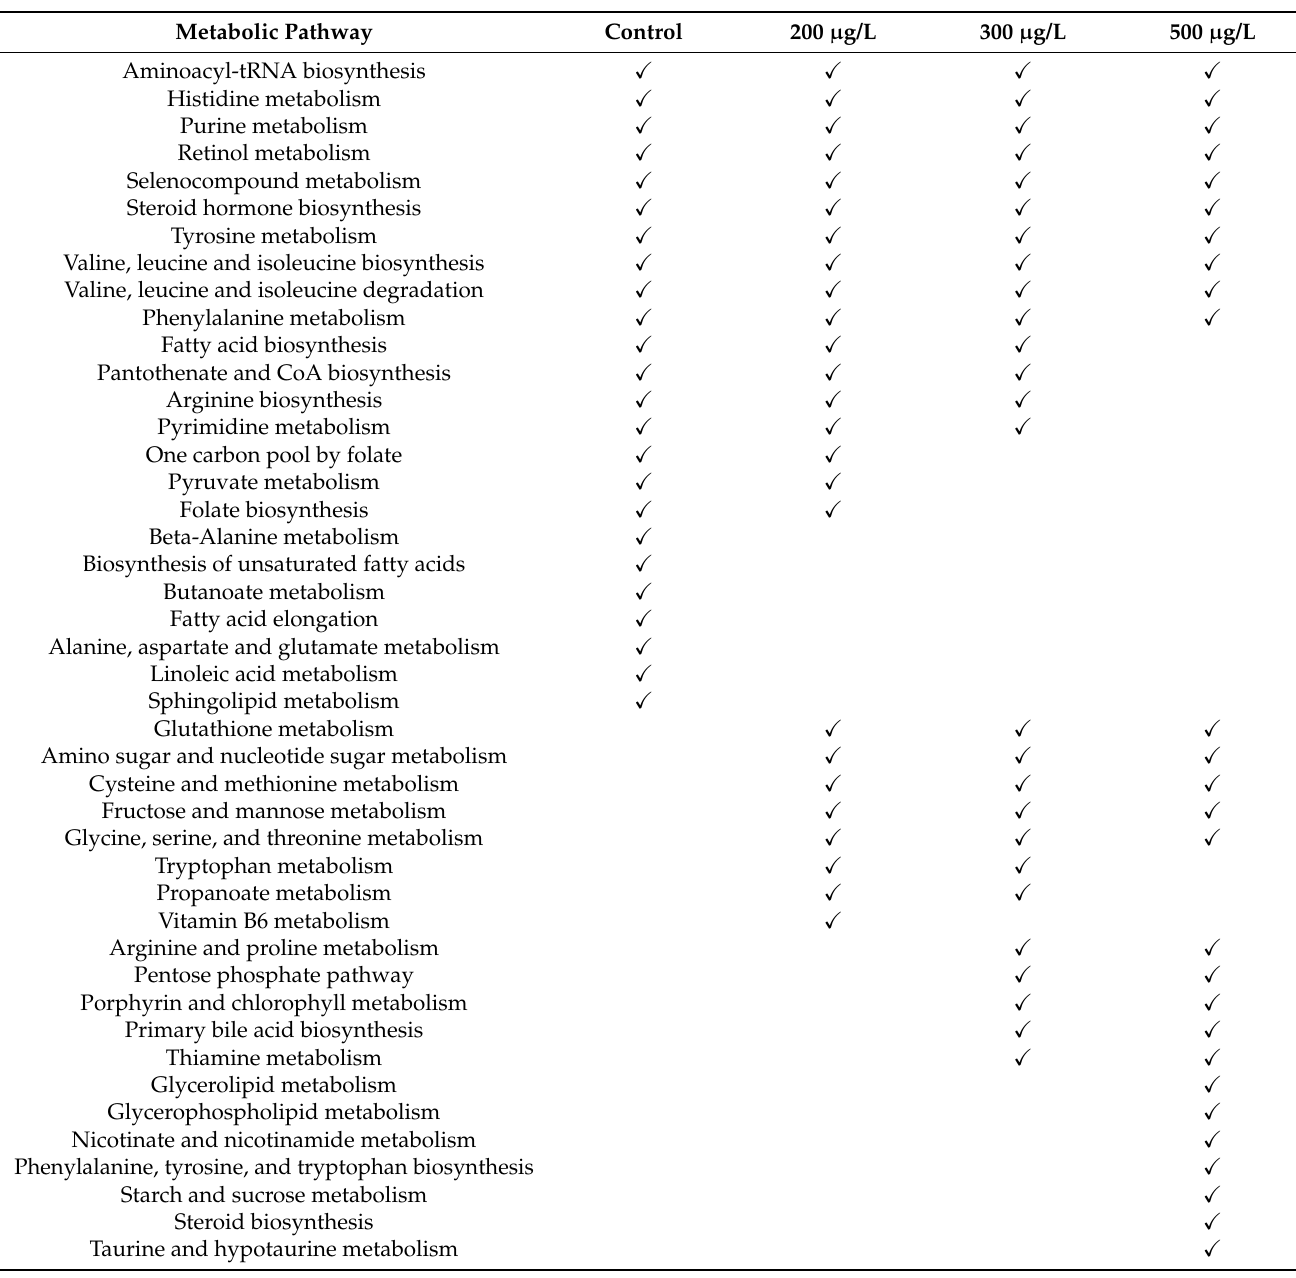
Table 1. Metabolic pathways identified in control, and individuals exposed to various concentrations of 2,6-DCBQ-OH specimens.